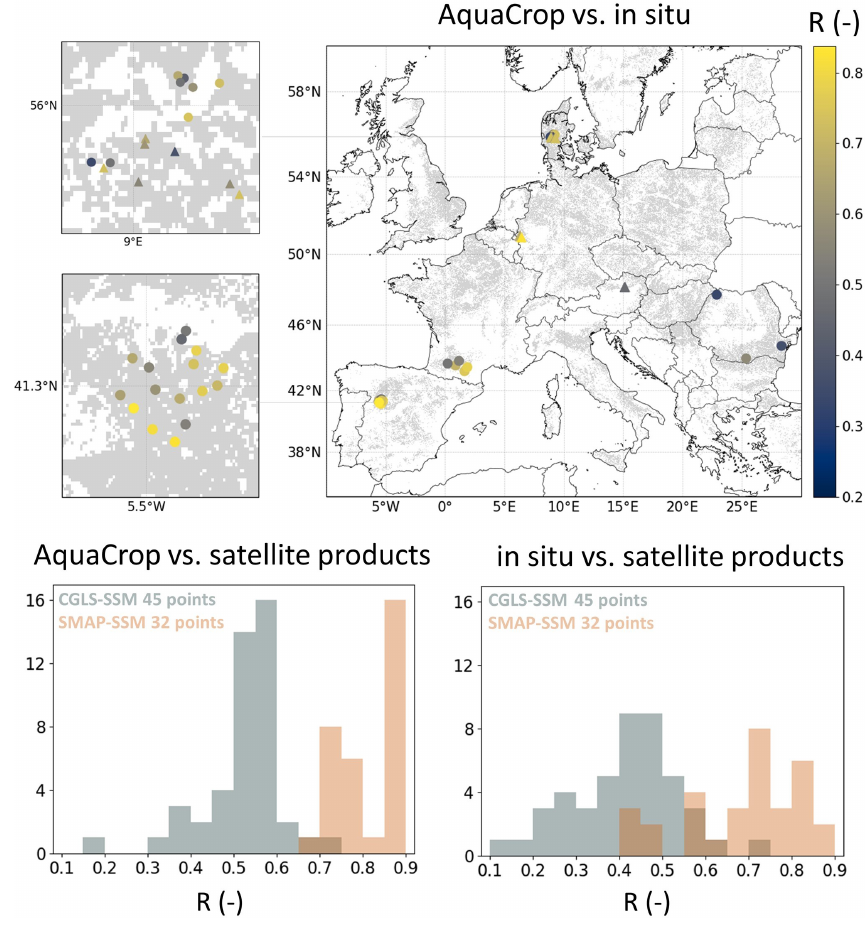
Figure 8. (a) Pearson correlation R values between in situ measurements from the ISMN and AquaCrop surface soil moisture at 45 locations over Europe, with grey pixels containing at least 50% rainfed agriculture according to the CORINE land cover map for 2012. Correlations shown are from cross-masked data with CGLS-SSM. The circles indicate the locations used for evaluations with both CGLS-SSM and SMAP-SSM, whereas triangles show locations that were only used for CGLS-SSM. (b) Histogram of R values between AquaCrop surface soil moisture and the two satellite products CGLS-SSM (45 points) in grey and SMAP-SSM (32 points) in orange at the locations of the in situ sites. (c) Histogram of the R values between the in situ measurements and the two satellite products CGLS-SSM (45 points) in grey and SMAP-SSM (32 points) in